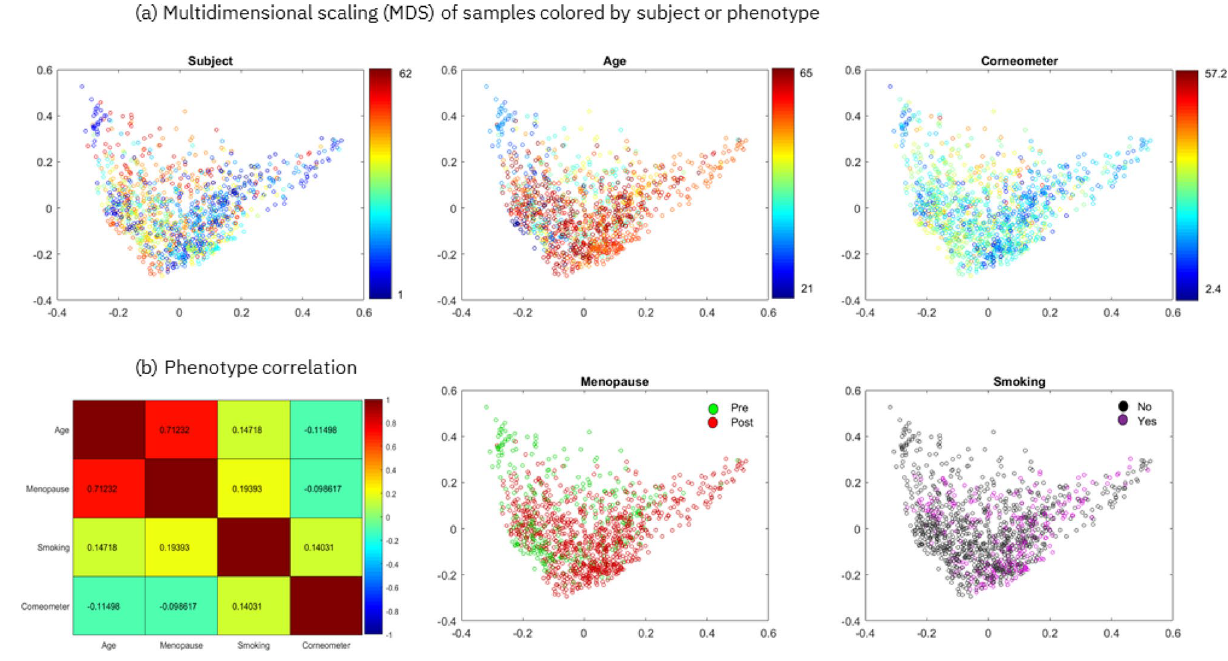
Figure 1. Multidimensional scaling (MDS) and phenotype correlation for the Canada cohort. ( a ) Multidimensional scaling of pairwise Bray–Curtis dissimilarities of 1200 samples colored by subject (the 62 subjects are each represented by a randomly selected color) or by phenotypic value. ( b ) Pairwise Spearman’s correlation is shown between each pair of phenotypes, except point-biserial correlation is shown when comparing binary vs. continuous phenotypes (the encoding for computing the correlation for the binary phenotypes is the following: smoking no/yes = 0/1, menopause pre/post = 0/1). The first two eigenvalues of the MDS represent 12% and 10% of the sum of all positive eigenvalues. This image has been generated using Matlab version R2017a at https ://www.mathw orks.com/produ cts/matla